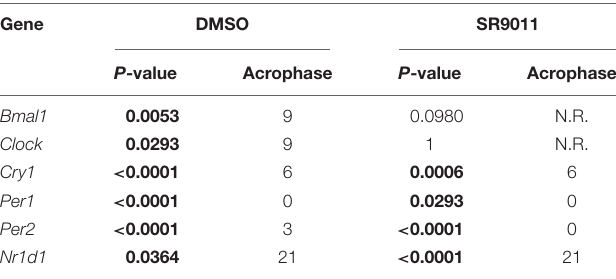
TABLE 2 | JTK_Cycle analysis of clock genes in primary microglia with